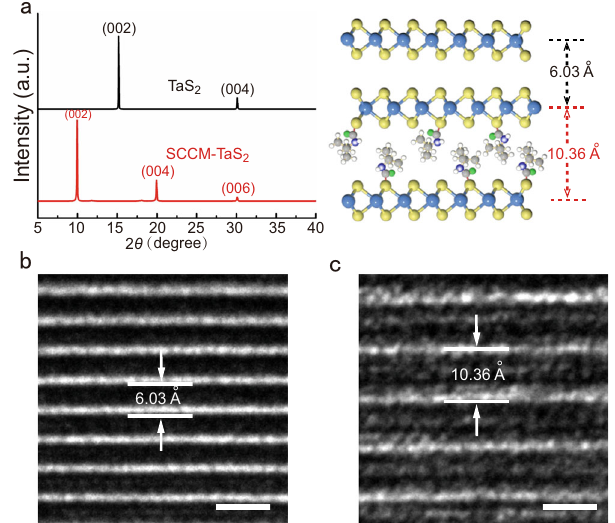
Fig. 2 | Structural characterization from the pristine TaS 2 and SCCM-TaS 2 hybrid structure. a XRD pattern and schematic of pristine TaS 2 single crystal and SCCM-TaS 2 hybrid structure. TEM characterization of TaS 2 single crystal ( b ) and SCCM-TaS 2 hybrid structure ( c ). (Scale bars,